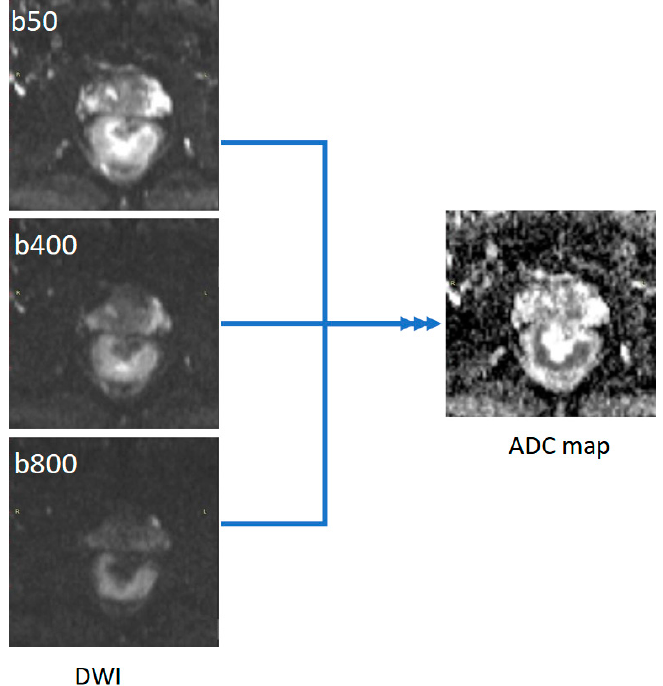
Figure 1. Example of ADC map generated from DWI images with three b values (50, 400, and 800). The parameters of the MRI sequences are provided in Table 1. No bowel preparation was received prior to the MRI